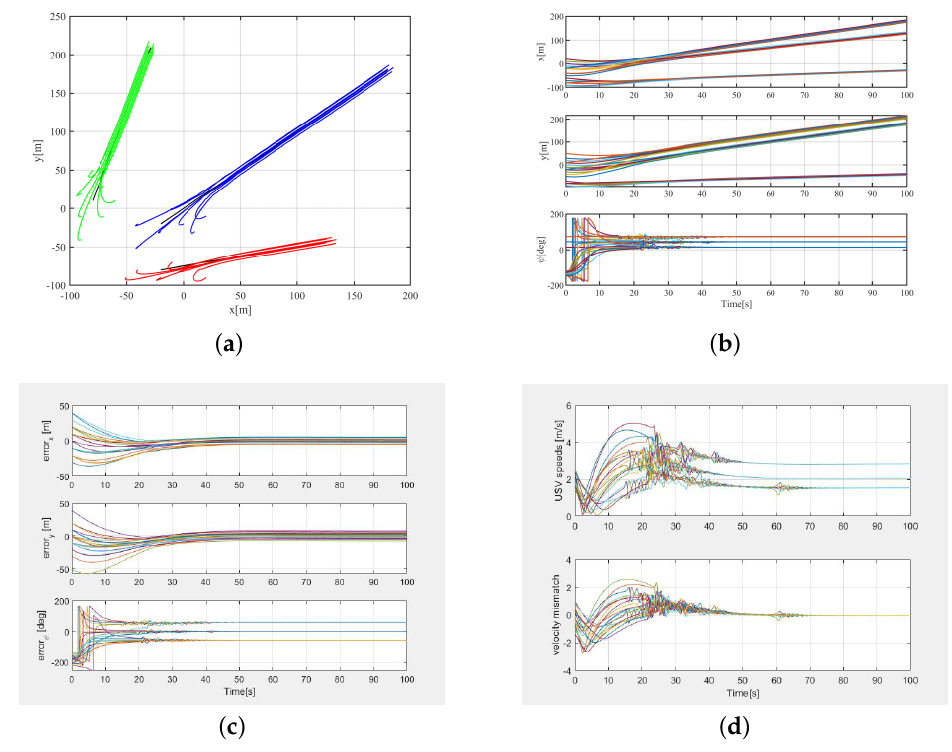
Figure 10. The simulation results using DSCA of Case 2. ( a ) Trajectories. ( b ) Positions and headings. ( c ) Tracking errors. ( d ) USV speeds and velocity